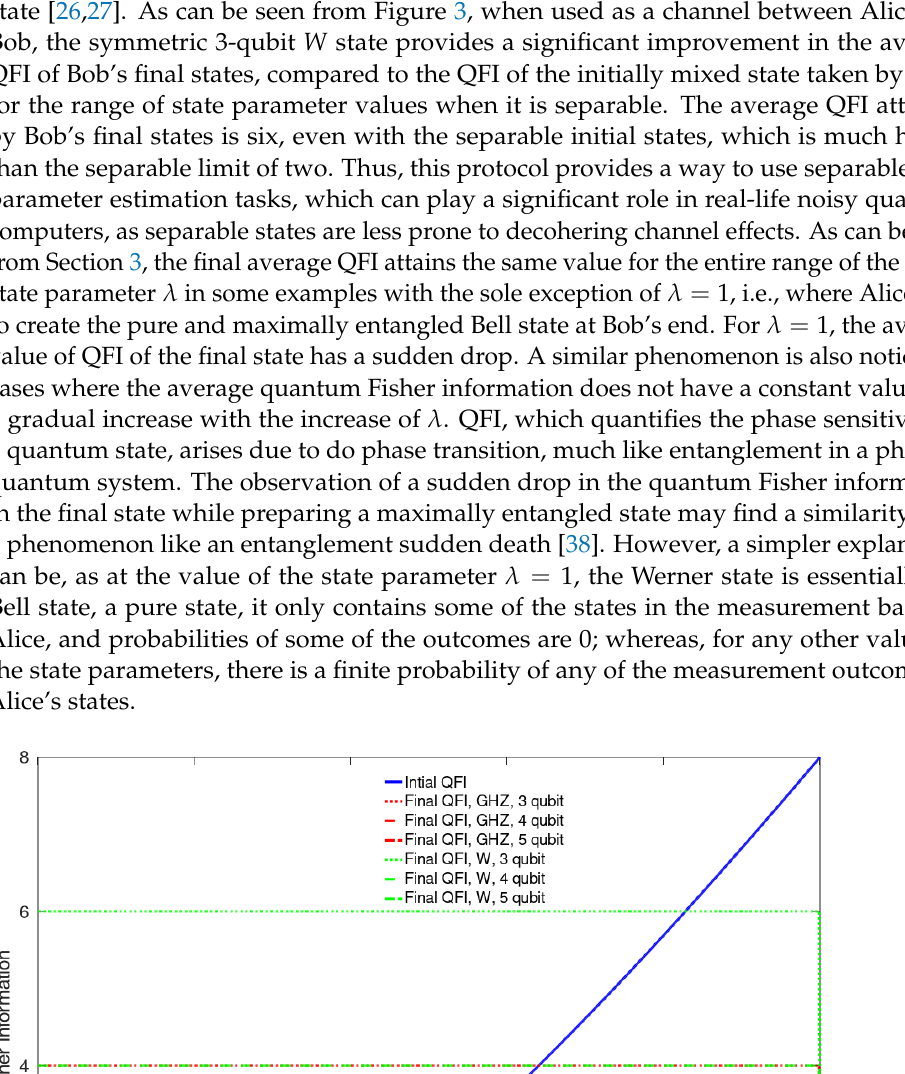
) as Alice’s measurement basis. The 2